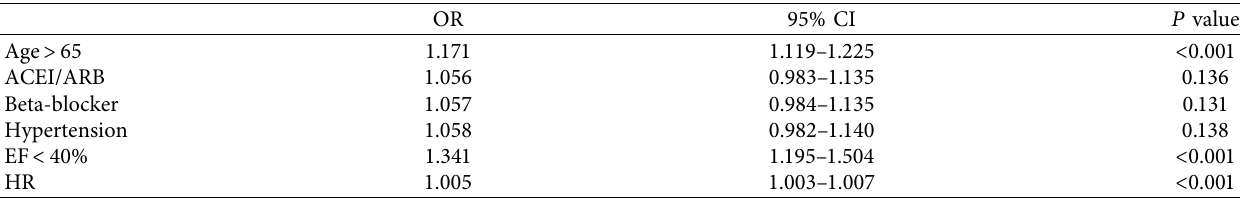
Table 1: Primary analysis: risk factors for a small increase in Scr within 48 h of hospital admission in patients with STEMI who underwent primary PCI.